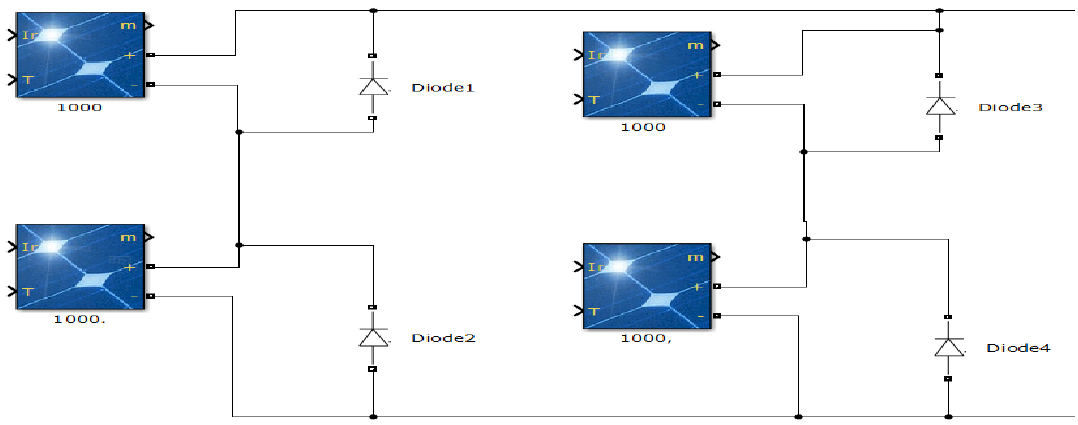
Figure 36. Test cases for 2S2P PV system configuration .